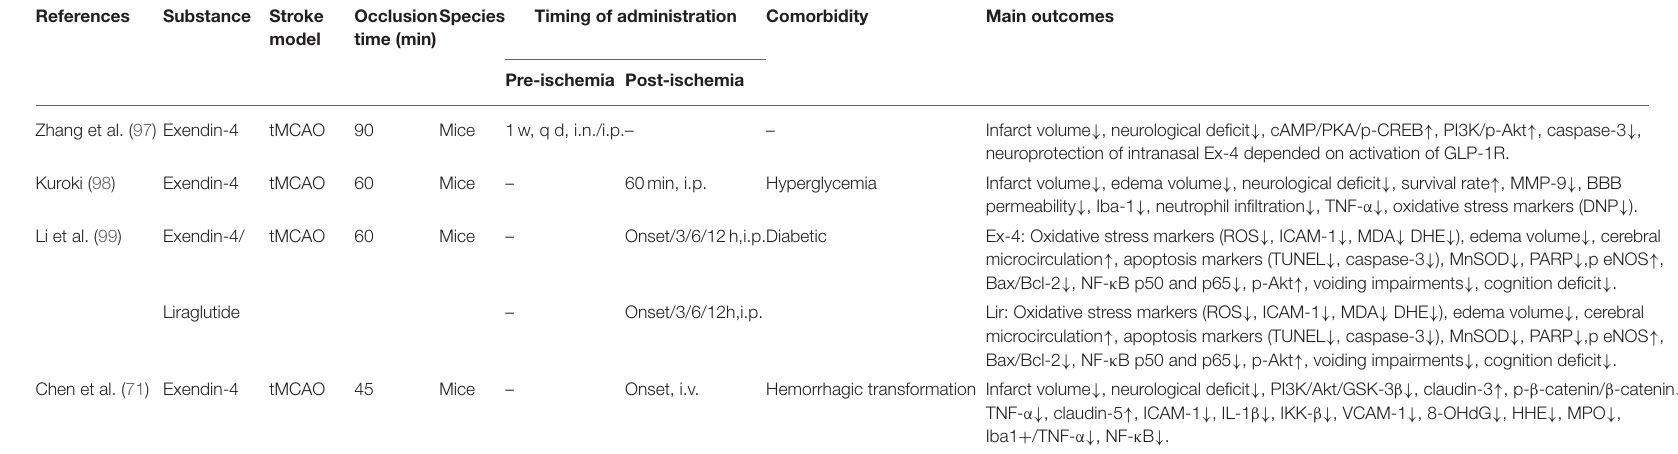
TABLE 2C | A review of preclinical studies of GLP-1 and GLP-1RAs in stroke.